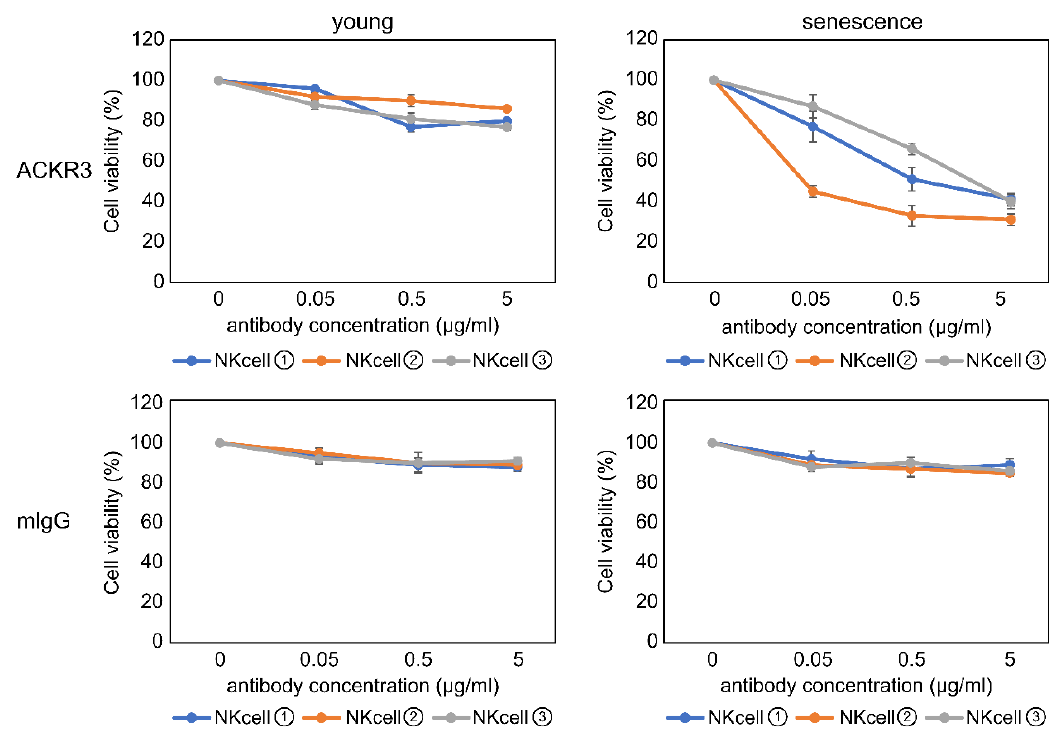
Figure 4. Eliminating ACKR3-positive senescent cells by antibody-dependent cellular cytotoxicity. All experiments were performed in triplicate.